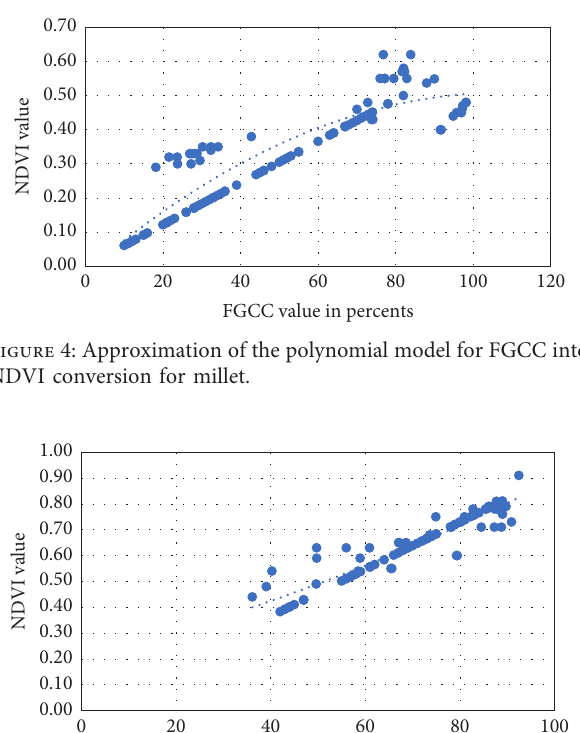
Figure 2: Approximation of the polynomial model for FGCC into NDVI conversion for sunflower.